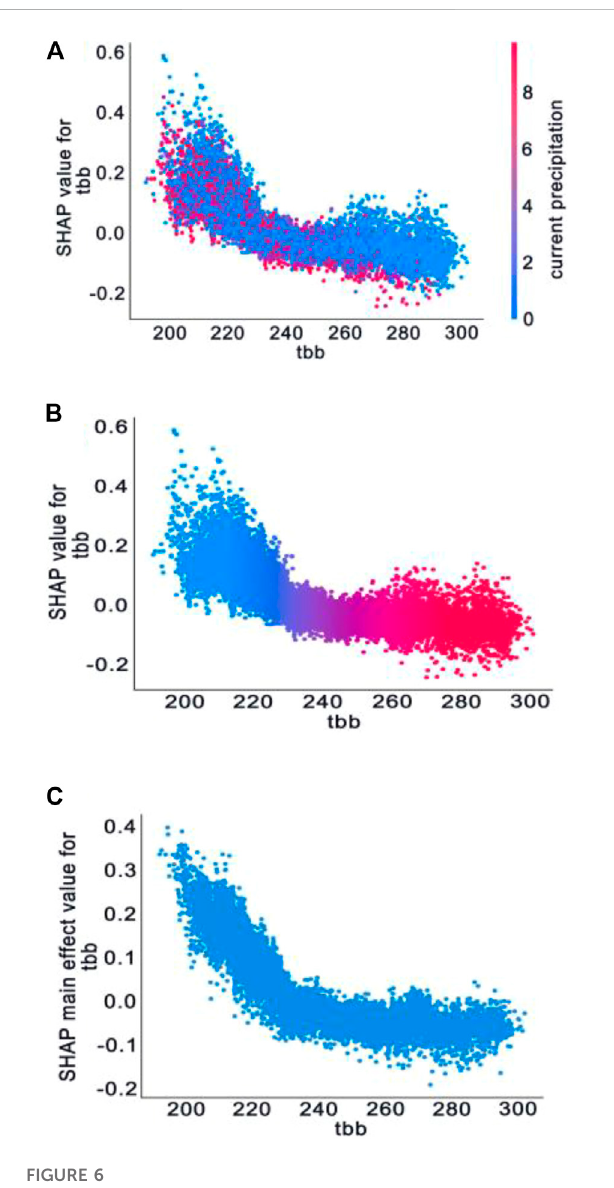
FIGURE 6 Characteristic-dependent plots of tbb (K): (A) feature dependency graph showing the interaction of current precipitation with tbb (K); (B) feature dependency graph that represents the comprehensive interaction of all the remaining input features on the tbb (K); (C) feature dependency graphs that eliminate